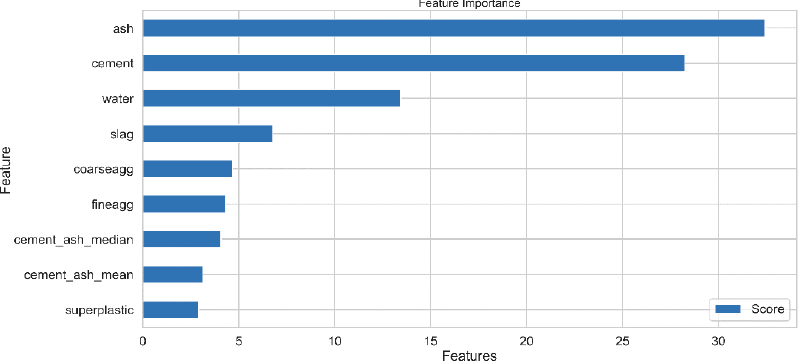
Figure 7. Importance of full combination characteristics: The importance of cement and fly ash combination is much higher than that of other characteristics, and is about twice of that of water and coarse aggregate.